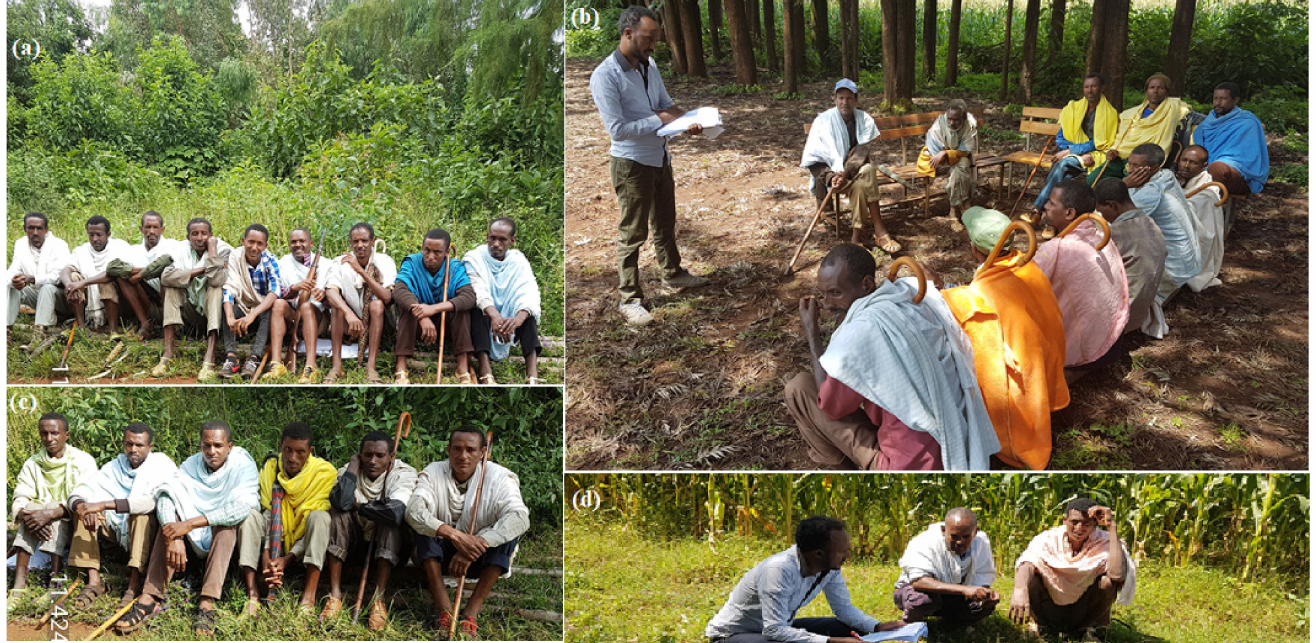
Figure 3. Photos showing group discussion ( a – c ) and interviewing ( d ) in koga irrigation scheme, photos by Desale taken in 2018. Field